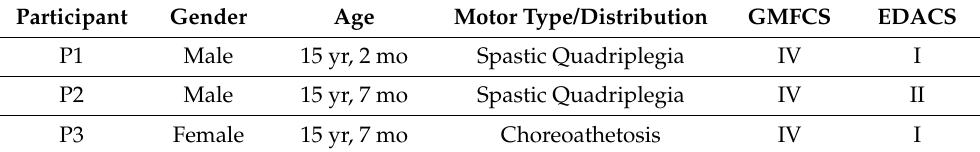
Table 1. Participant characteristics at commencement of the ParaSTART Program. Participant Gender Age Motor Type/Distribution GMFCS EDACS P1 Male 15 yr, 2 mo Spastic Quadriplegia IV I P2 Male 15 yr, 7 mo Spastic Quadriplegia IV II P3 Female 15 yr, 7 mo Choreoathetosis IV